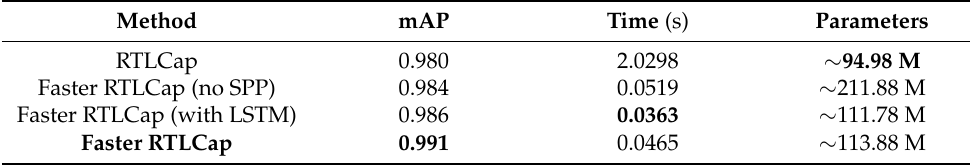
Table 3. The performance comparison results between RTLCap and Faster RTLCap.